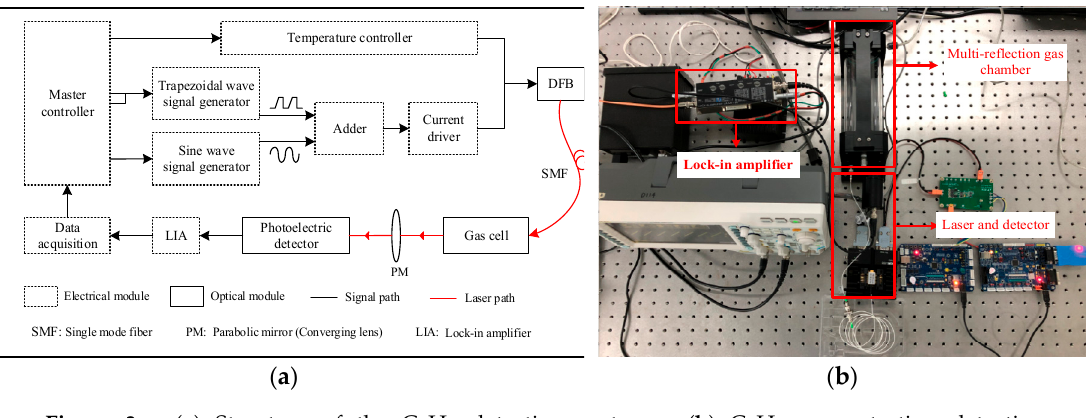
Figure 3. ( a ) Structure of the C 2 H 2 detection system. ( b ) C 2 H 2 concentration detection experimental platform.